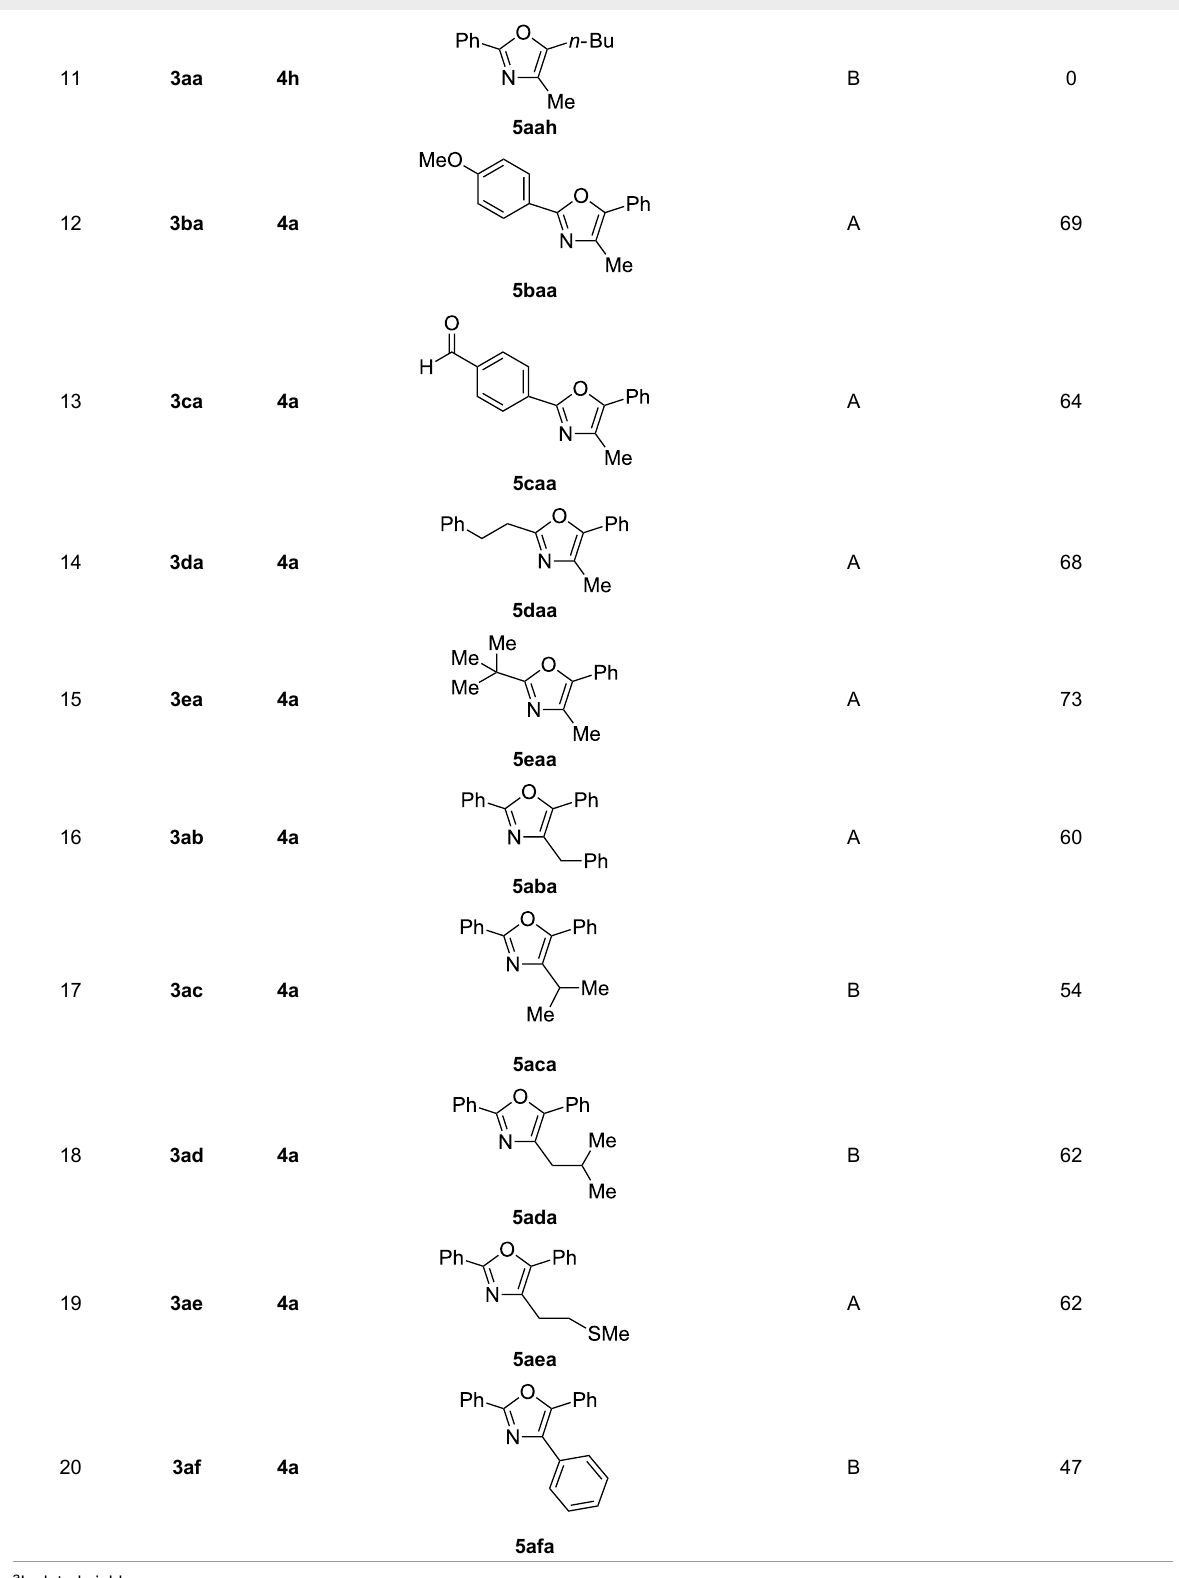
Table 3: Synthesis of various trisubstituted oxazoles.